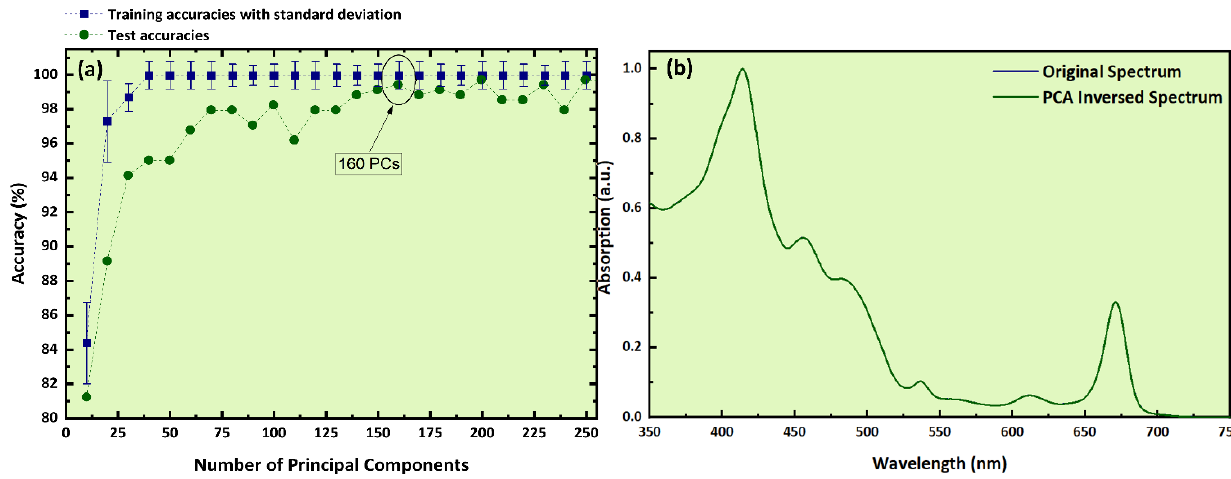
Figure 8. ( a ) Training and test accuracies as a function of the number of PCs, ( b ) experimental absorption spectrum and PCA-inversed spectrum. Table 4. ( a ) Classification report and ( b ) confusion matrix for SVC external validation.